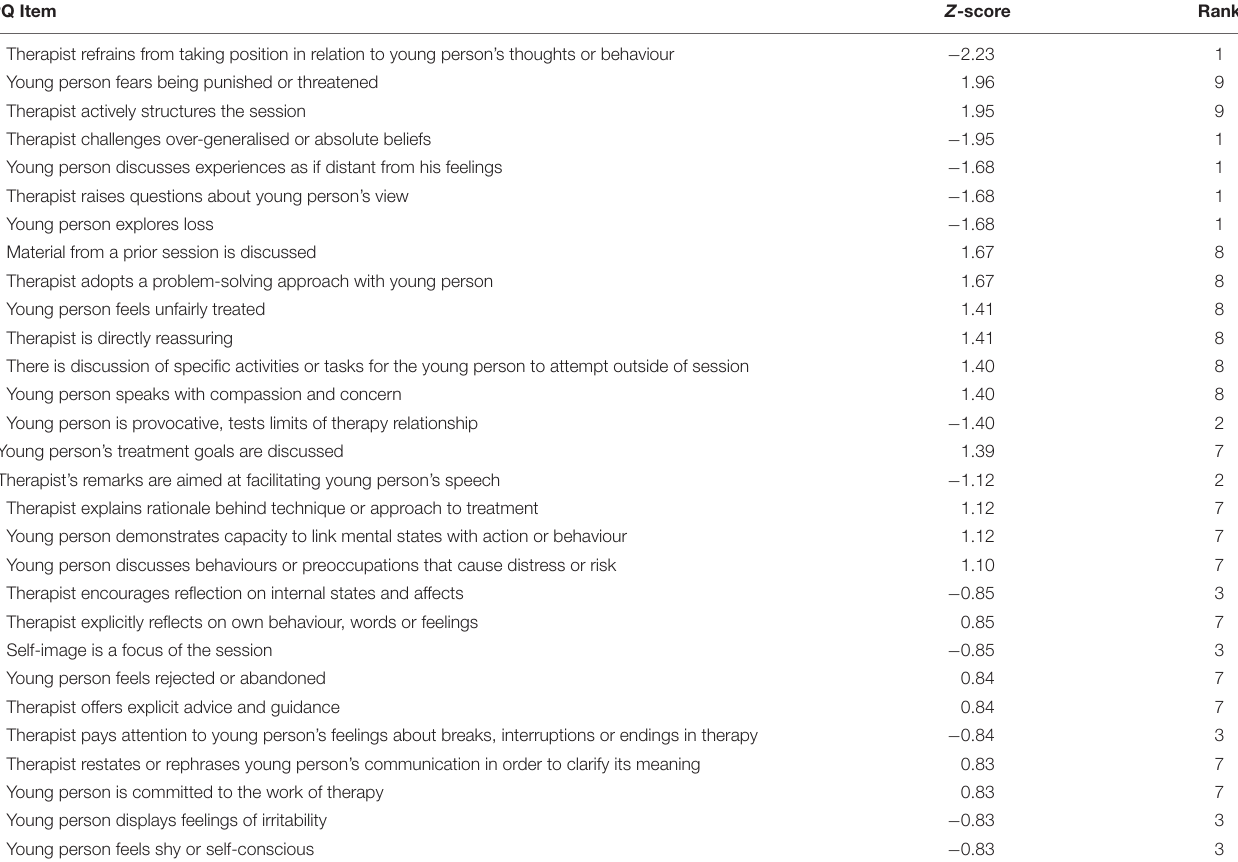
TABLE 5 | Interaction structure 3: “Mismatch and incongruence in perception and communication.” APQ Item Z -score